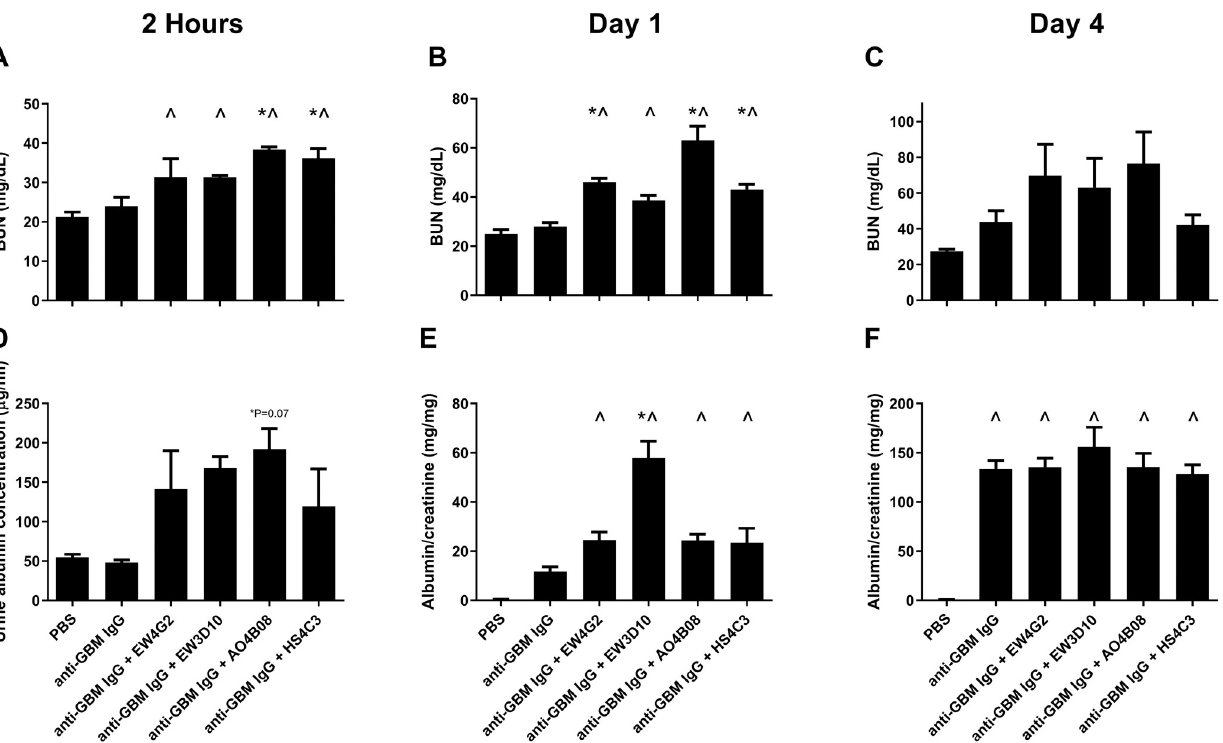
Fig 3. Co-injection of anti-HS antibodies during anti-GBM-induced glomerulonephritis induces a transient increase in albuminuria and decline in renal function. Blood urea nitrogen (BUN) levels after (A) 2 hours, (B) 1 day and (C) 4 days. Urinary albumin concentration after 2 hours (D) and urinary albumin:creatinine ratios after (E) 1 day and (F) 4 days anti-GBM-induced glomerulonephritis. Results are expressed as means ± s.e.m. from four mice in each group. ^ P < 0.05 vs. PBS-injected mice. � P < 0.05 vs. anti-GBM IgG-injected mice.